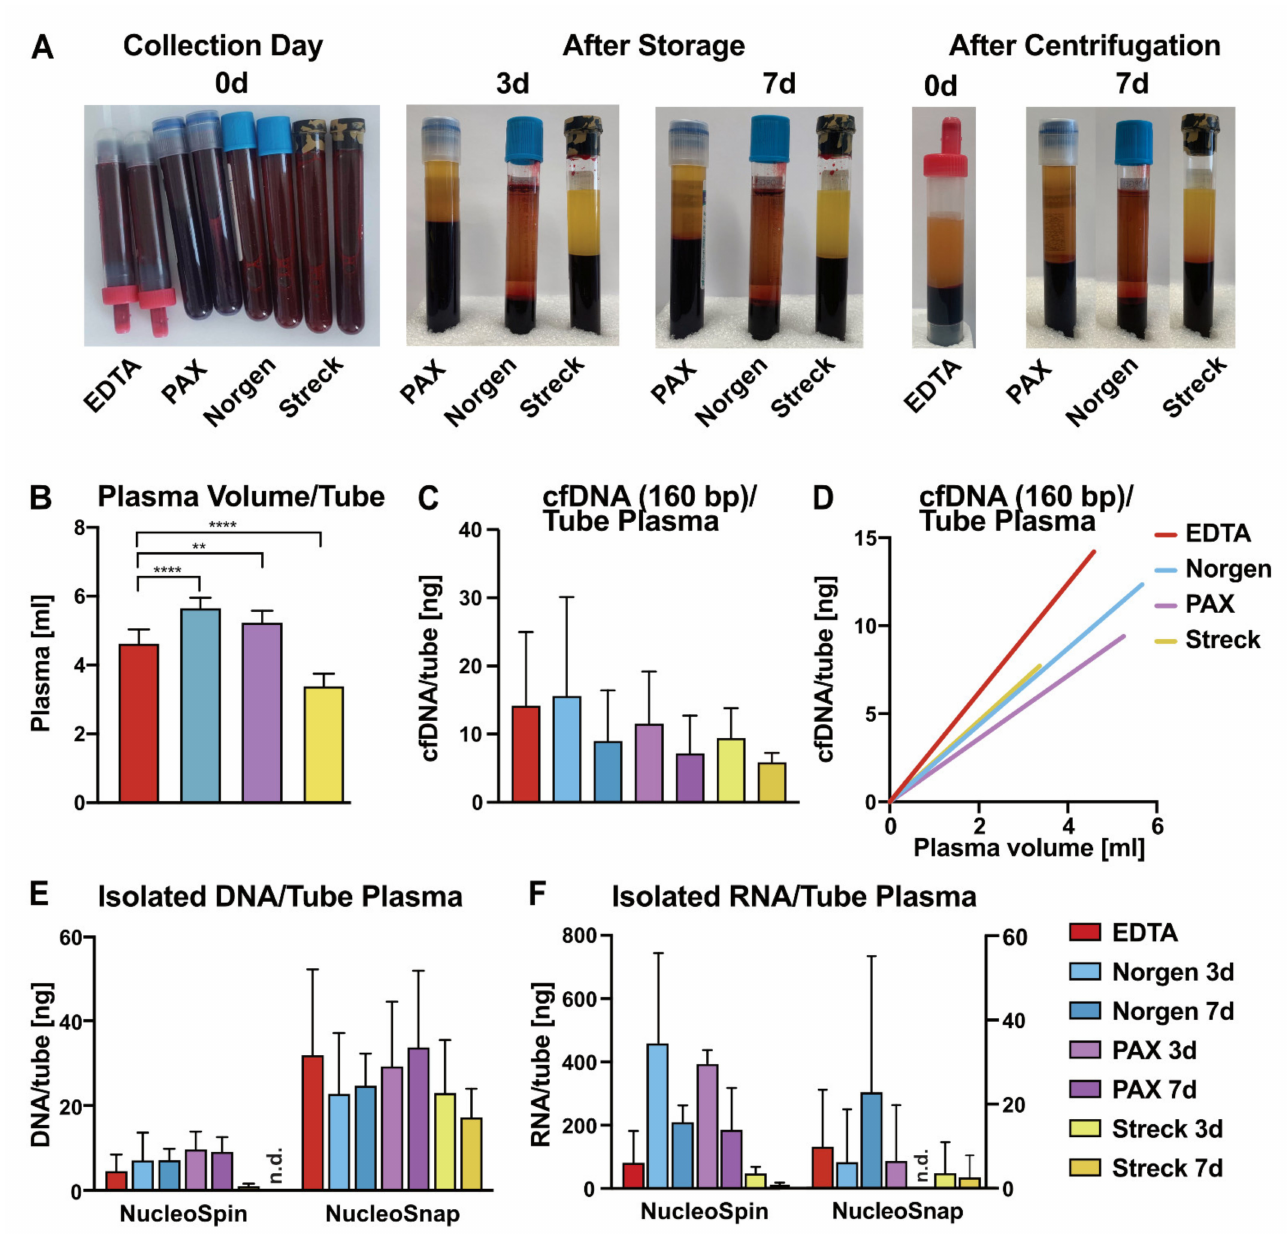
Figure 1. Comparative analysis of blood conservation tubes. ( A ) Representative images of blood collected in EDTA, PAX, Norgen, and Streck tubes at the same time point from the same healthy donor for a direct comparison of tube performance. Pictures were taken right after blood drawing (left), after 3 d (middle left), after 7 d (middle right), and after plasma processing by centrifugation (right). ( B ) Mean plasma volumes obtained from indicated blood conservation tubes after centrifugation ( n = 4). ** p < 0.01, **** p < 0.0001 as determined by Kruskal–Wallis test ( C ) The mean concentration of cfDNA recovered from indicated tubes isolated by NucleoSnap quantified on Bioanalyzer profile (BA). The size of DNA wrapped around one nucleosome can range from around 146 to 176 bp and is represented by 160 bp ( n = 4). ( D ) cfDNA yield per plasma volume calculated for the different tubes. Concentration is defined as cfDNA (160 bp, measured by BA) per plasma volume ( n = 4). ( E , F ) Mean Qubit concentration of total DNA ( E ) and total RNA ( F ) recovered from indicated tubes isolated by NucleoSpin (left) or NucleoSnap (right). n.d. indicates not detectable values. When no specific time point is indicated, values represent the mean of both time points ( n =